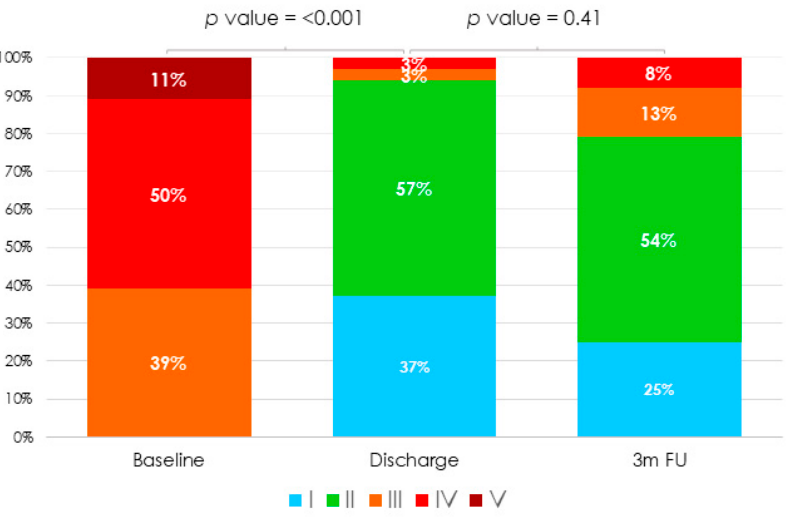
Figure 1. Tricuspid Regurgitation severity at baseline, discharge and three-month follow-up.